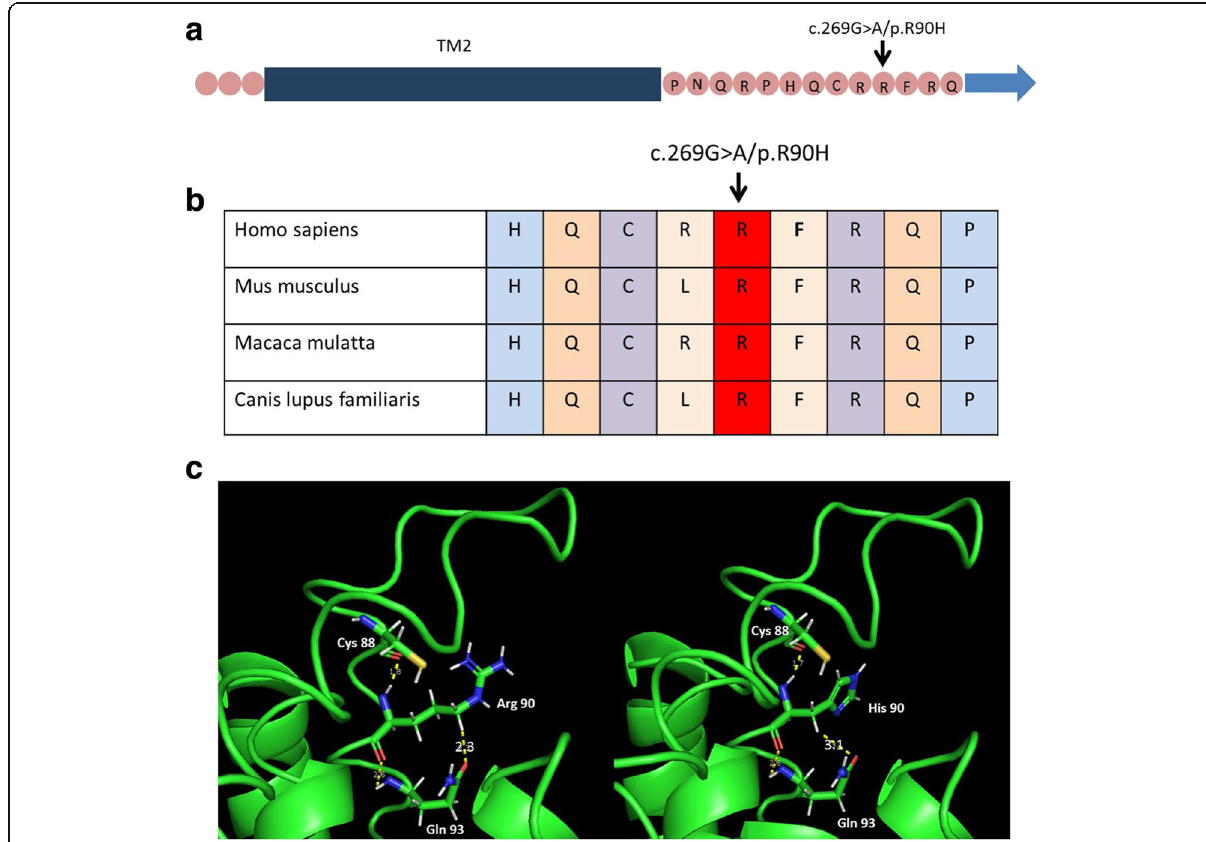
Fig. 2 c.269G>A/p.R90H mutation identified in the RHUC patient. a This mutation is located close to the second transmembrane region (TM2) as indicated by the black arrow. b This identified amino acid substitution displays high evolutionary conservation among different species as indicated by the black arrow. c 3-D structures of the wild-type and c.269G>A/p.R90H URAT1 proteins with prediction software. The left shows the structure of the wild type. The right shows the structure of p.R90H. The hydrogen bond between His90 and Gln93 in the mutant is weakly formed (bond length is 3.1 Å) in comparison with the wild type (bond length is 2.3